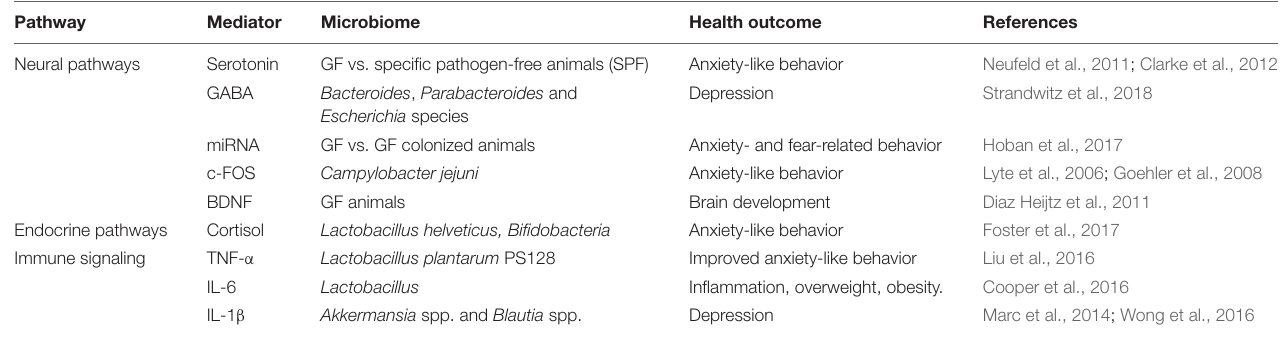
TABLE 1 | Molecular signaling pathways linking the microbiome with stress-related health outcomes.